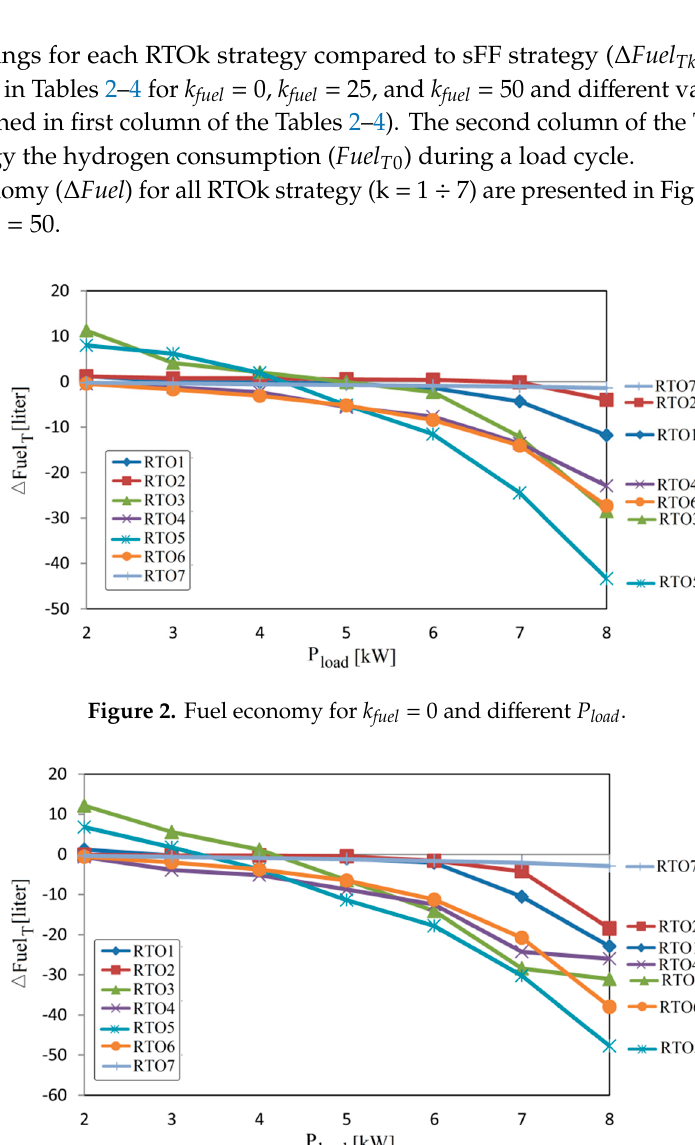
Table 4. Fuel economy for k fuel = 50 and different P load .